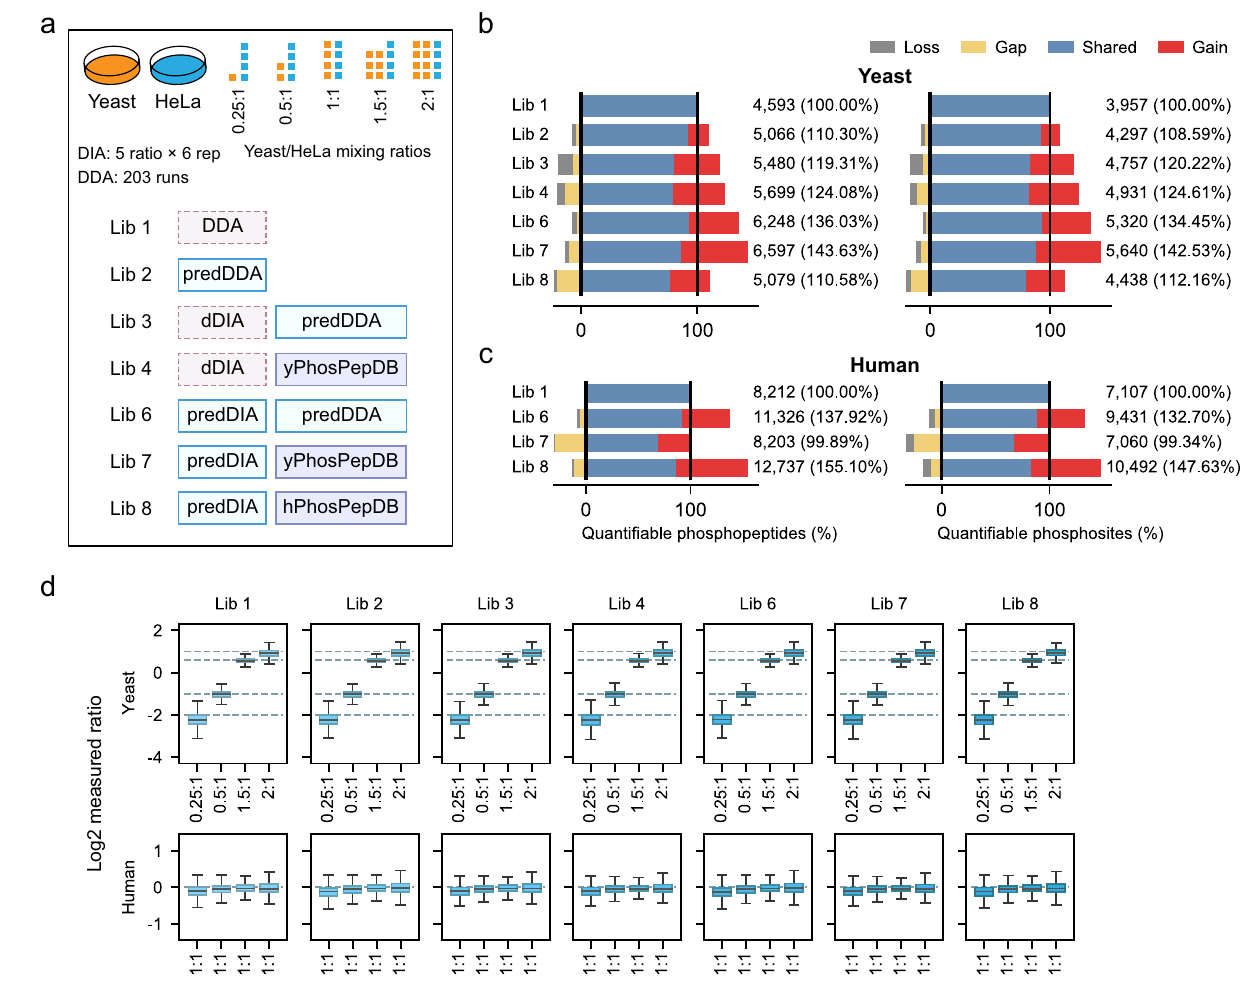
Fig. 6 Accurate quanti fi cation of the phosphoproteome in a two-proteome model. a Experimental design of the yeast/human two-proteome model and generation of the project-speci fi c DDA library (Lib 1) and six DeepPhospho predicted libraries (Lib 2 to Lib 8). yPhosPepDB, a predicted library built from a previous yeast phosphoproteomic dataset. Other library abbreviations are de fi ned in Fig. 3a. b , c Number of phosphopeptides and phosphosites from the yeast ( b ) and human ( c ) proteome that were quanti fi ed from the iterative search using each library. Percentage of the total quanti fi able phosphopeptide or phosphosite number is shown for each predicted library relative to Lib 1. The proportions of shared identi fi cations (IDs), gained IDs, lost IDs, and gap IDs yielded by Lib 2 to Lib 7 are indicated in different color compared to Lib 1. d Boxplots of measured ratios for yeast phosphopeptides (upper) and human phosphopeptides (lower) at different dilution conditions determined by DIA data analysis with each library. Ratios were calculated based on the mean quantities in six replicates of each sample. Expected ratios are indicated by dashed lines and in the x-axis. Boxplot center line, median; box limits, upper and lower quartiles; whiskers, 1.5× interquartile range. Source data for this fi gure are provided as a Source data fi